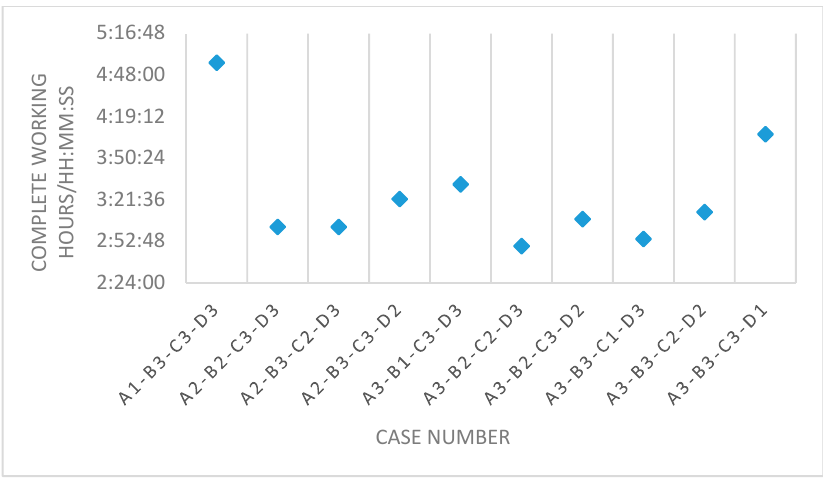
Figure 16. Completion time under 10 AGVs.